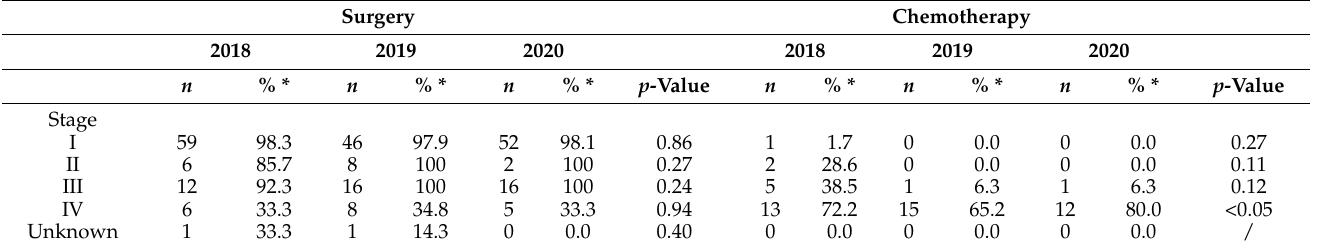
Table 2. Reggio Emilia Cancer Registry. Years 2018–2020. Number of cases by stage and therapy per year. Surgery Chemotherapy